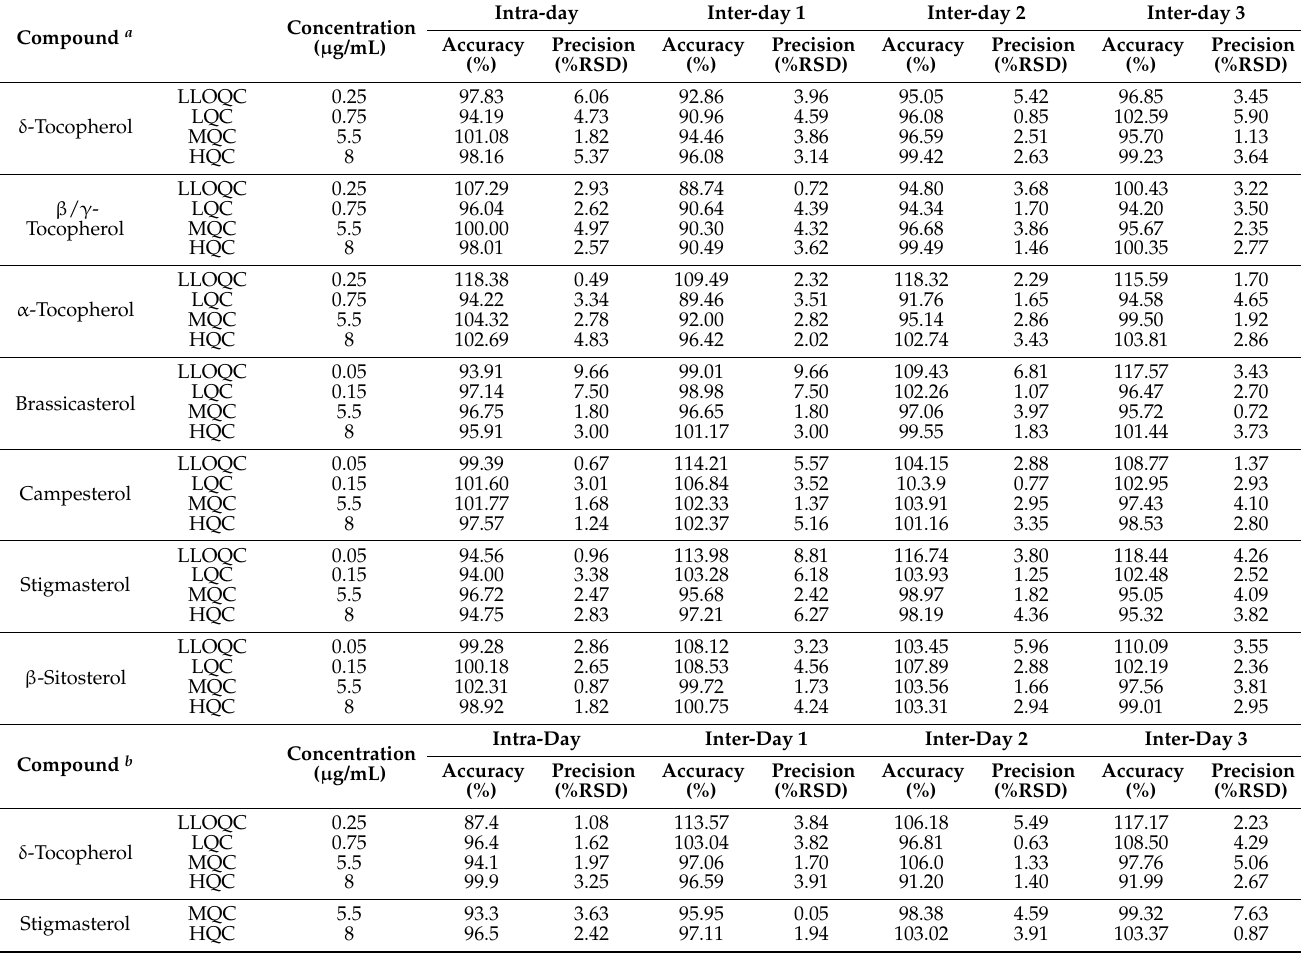
Table 3. Inter-day and intra-day accuracy and precision of phytosterols and tocopherols prepared in surrogate matrix a and sample matrix b ( n = 4). Compound a